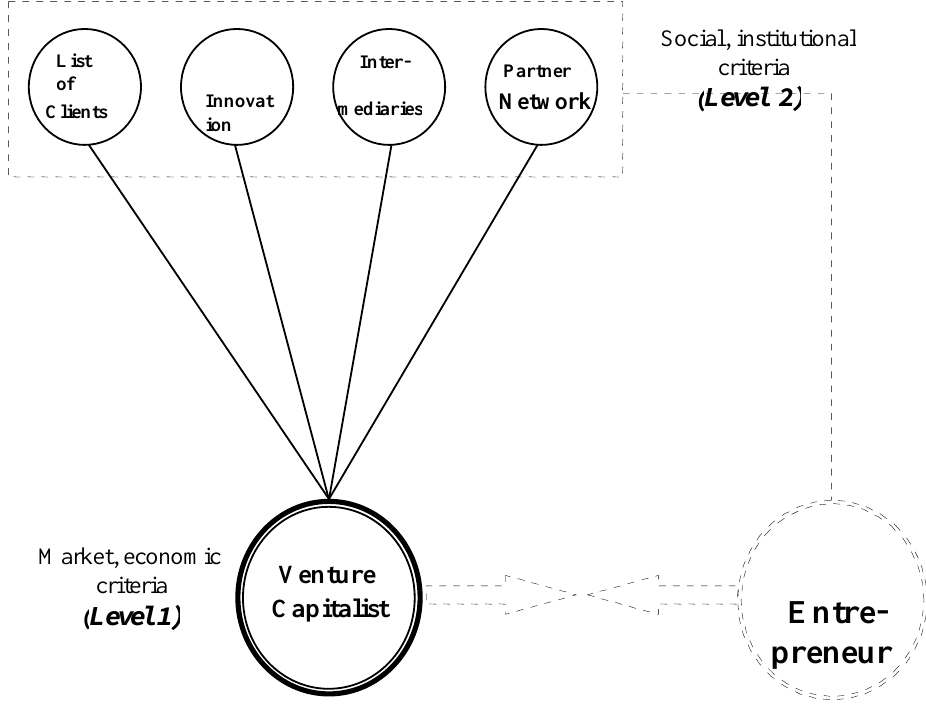
Figure 2. Venture Capitalists and Entrepreneurs - Institutional